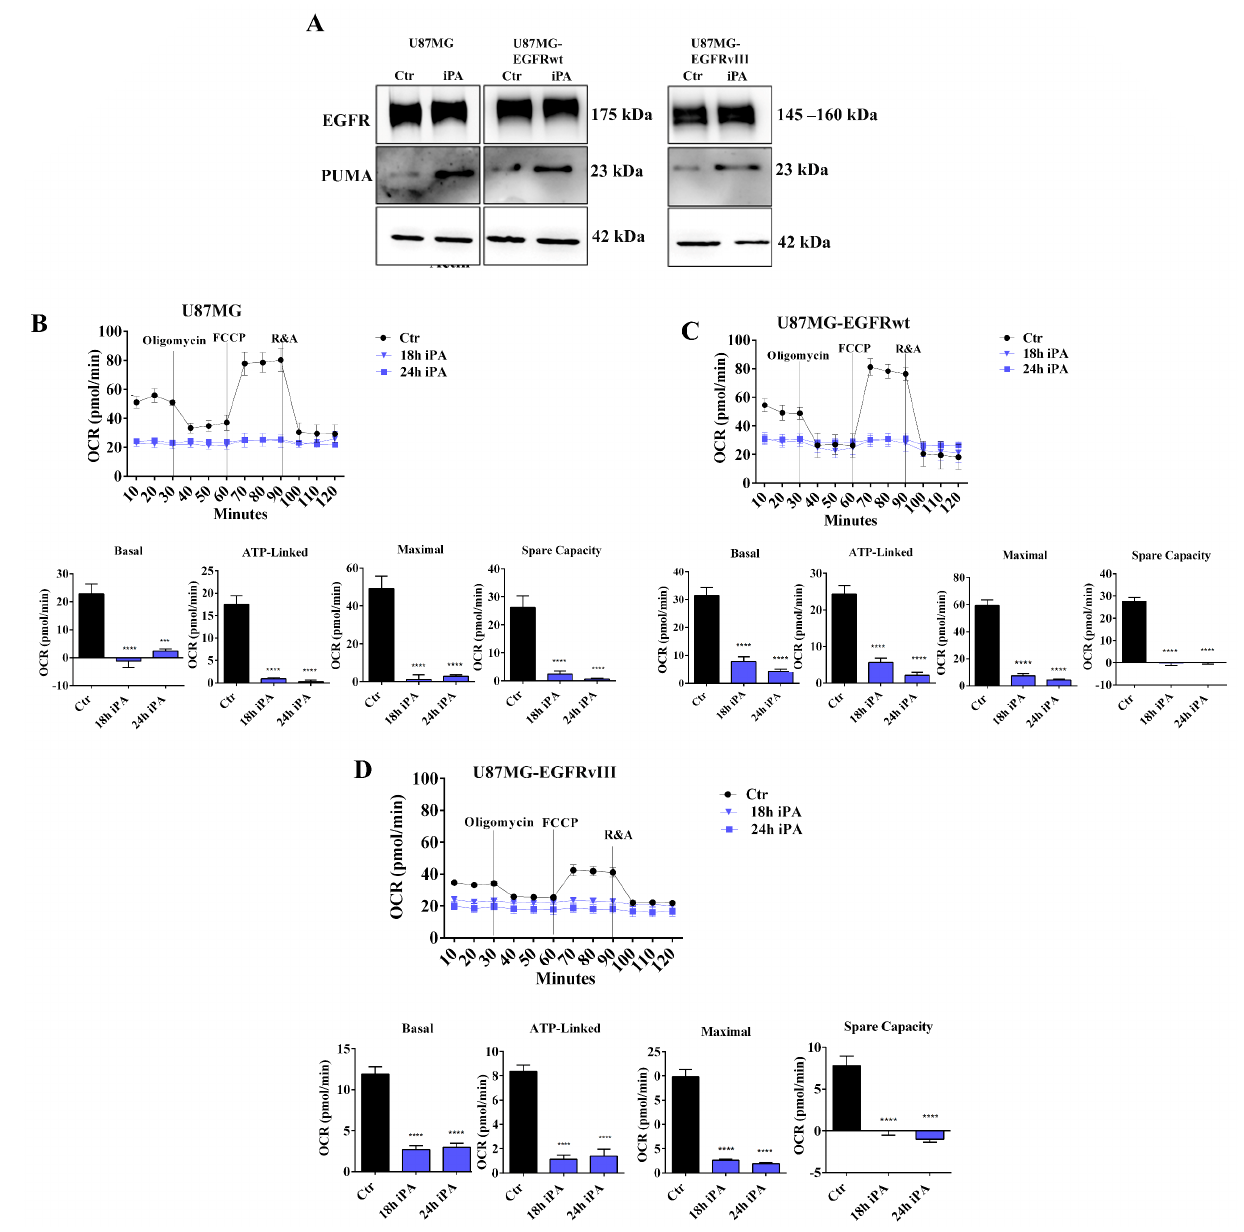
Figure 1. iPA impaired mitochondrial metabolism in GBM stabilized cell lines. ( A ) Representative immunoblotting images of EGFR and PUMA protein levels in U87MG, U87MG − EGFRwt, and U87MG − EGFRvIII cells after iPA treatment. Kinetic profile of oxygen consumption rate (OCR) of U87MG ( B ); U87MG − EGFRwt ( C ); U87MG − EGFRvIII ( D ) cells, treated or untreated with iPA for 18